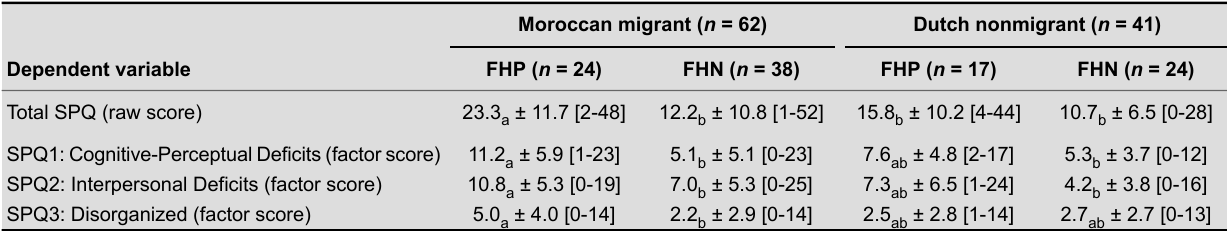
Schizotypal Personality Questionnaire Scores as a Function of Migration Status and Family History (N =